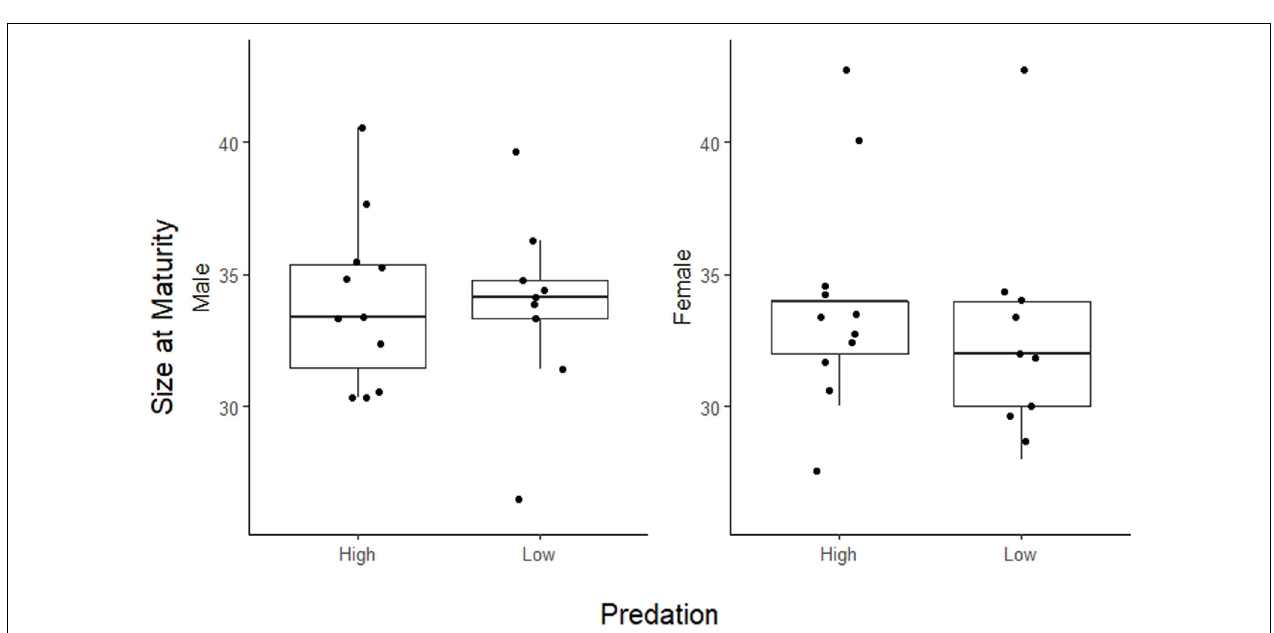
Frontiers in Ecology and Evolution |